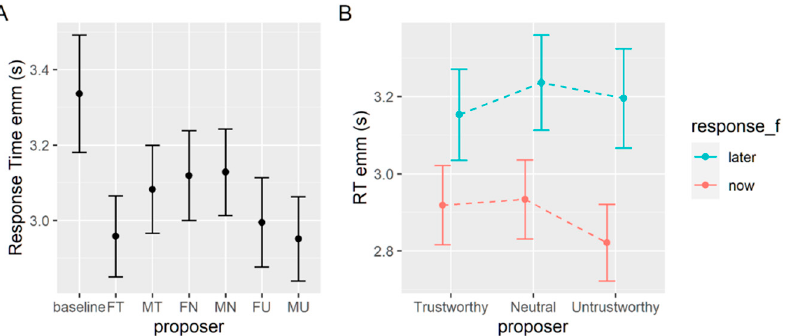
Figure 4. ( A ) Estimated marginal means of response times in seconds for the baseline and each experimental condition in the delay discounting task. ( B ) Estimated marginal means of response times for each level of trustworthiness when the preference was for the immediate (red) or delayed (blue) options. Only the main effect of response is significant, but the plot shows the non-significant interaction for ease of comparability with similar figures in the paper.